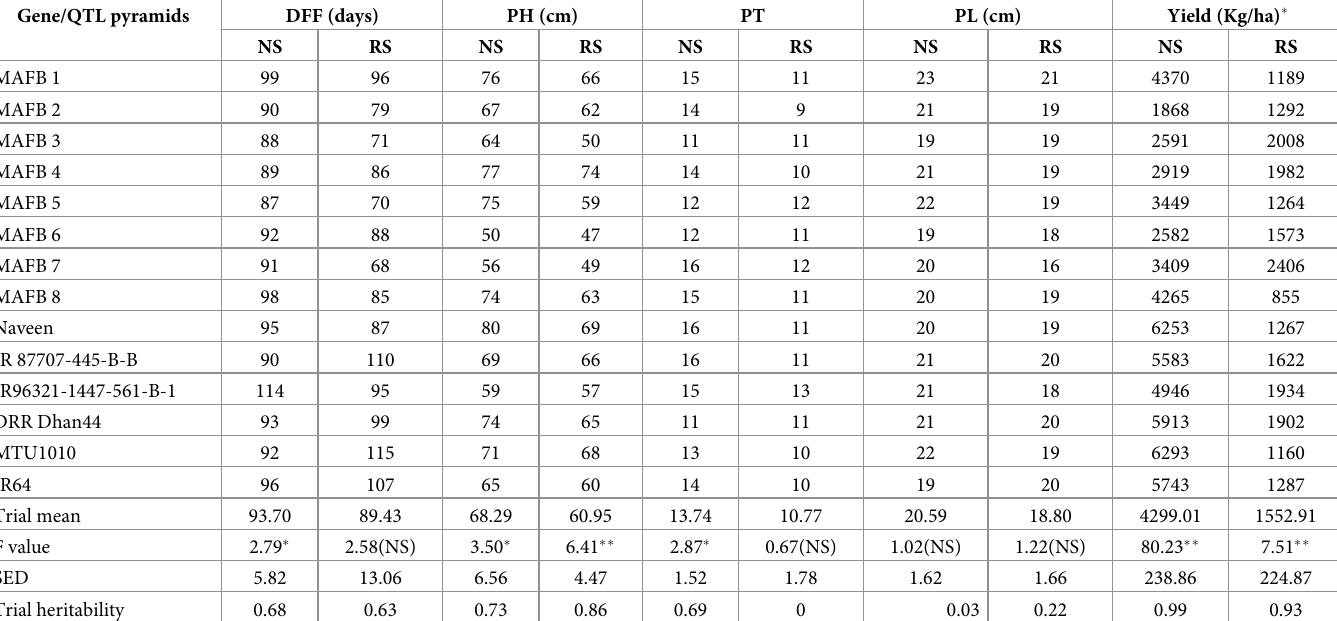
Table 3. Agronomic and yield performance of pyramided lines developed through the MAFB approach. Gene/QTL